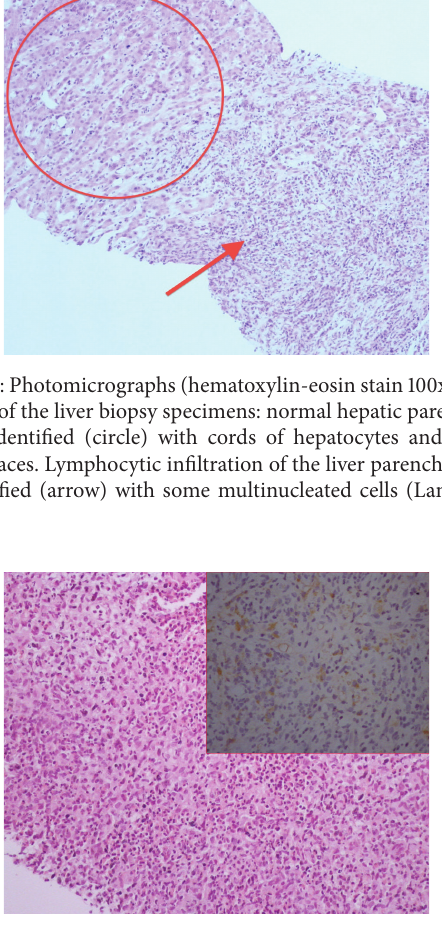
Figure 7: Photomicrographs (hematoxylin-eosin (H-E) stain 200x magnification and CD1a immunolabeling) of the liver biopsy speci- mens: lymphocytic infiltrate is identified with multiple Langerhans cell intermixed that stain positive to CD1a, compatible with liver involvement of LCH.